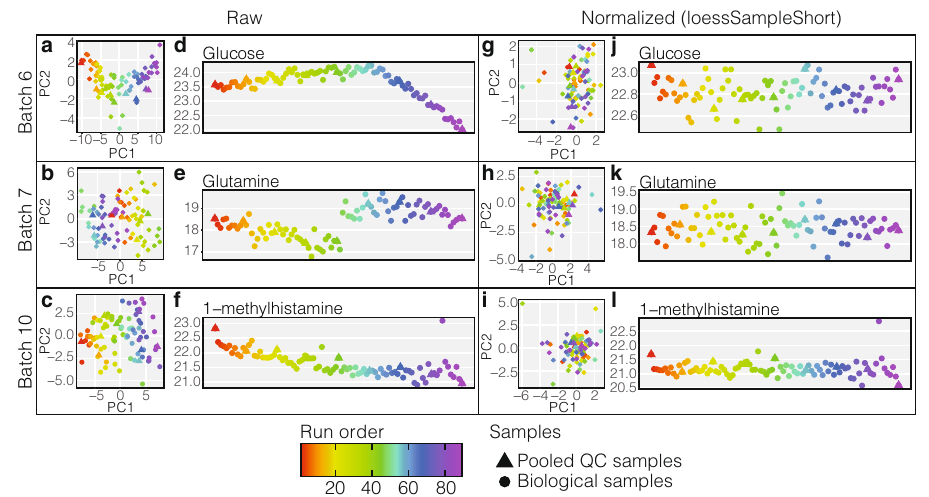
Fig. 2 Examples of typical technical variations and signal drifts within each batch for different metabolites and comparison to normalised data. (Note vertical scale change.). a – c PCA plots of raw data in batches 6, 7 and 10 respectively, each marker is coloured by the sample run order. d – f Run plots exhibiting metabolite signal drift for glucose, glutamine, and 1-methylhistamine respectively, for their respective batches. g – i PCA plots from the same batches as a – c respectively with intra-batch normalised data using loessSampleShort method. j – l Run plot for the metabolites and batches illustrated in d – f but with intra-batch data normalised using loessSampleShort method. Source data are provided as a Source Data fi